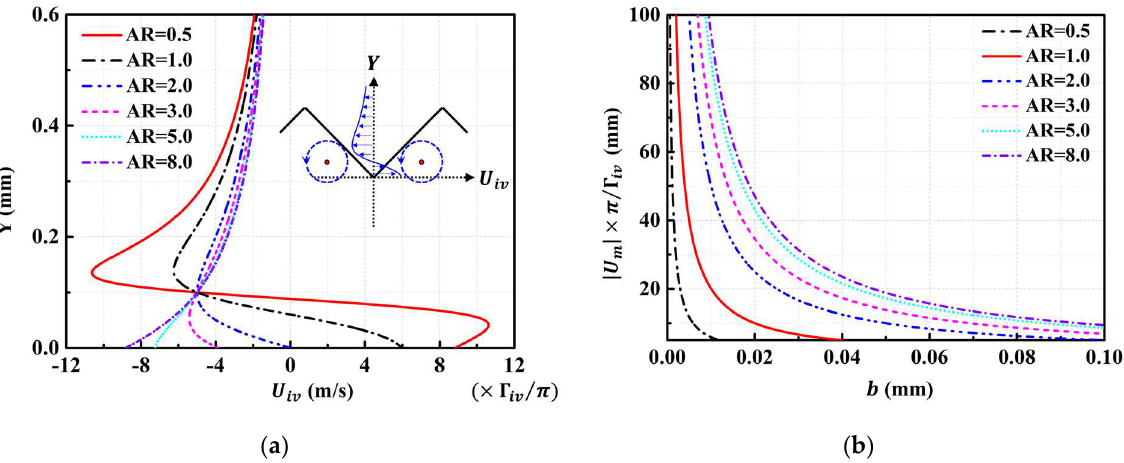
Figure 6. Influence of geometric parameters on velocity distribution within the groove. ( a ) Variation in velocity profiles induced by image vortices with AR at the groove centerline when b is a constant value and h = 0.2 mm; ( b ) variation in the virtual distance R vd representing the total induced velocity with b and AR at the center of the boundary vortex.